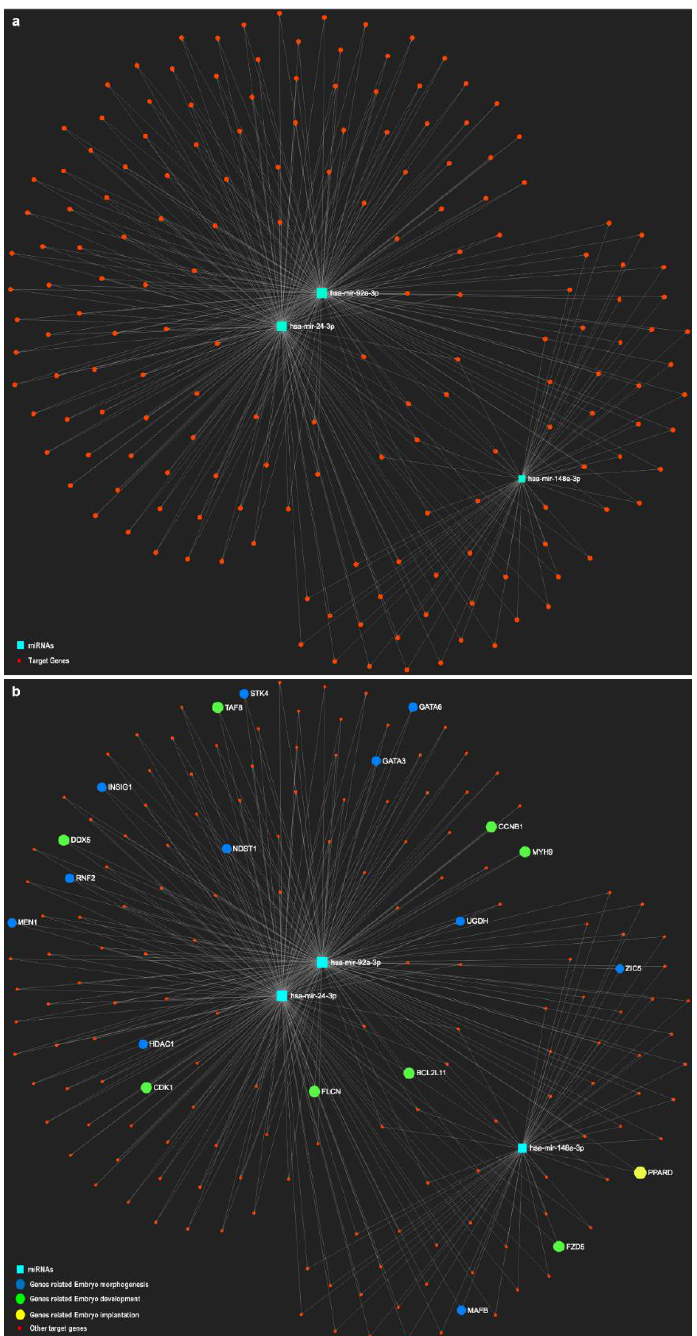
Figure 2. Networks of selected miRNAs identified in oviductal extracellular vesicles (oEVs) and contained in the embryo according to miRNet online tool with potential target genes involved in embryo development. The miRNet online tool was used to represent selected miRNAs (13) (turquoise-blue nodes) based on differential expression and high abundance in oEVs at stage 1 of the bovine estrous cycle (recently ovulated follicle; days 1-4 post-ovulation) and potential target genes (red nodes) enriched in functional categories related to embryo development (green), embryo morphology (blue) and implantation (yellow) in a network. Since the miRNet online tool allows to choose the source/tissue for the list of miRNAs, the network ( a ) represents three miRNAs contained in embryos according to the online tool database, with all target genes involved in embryo development functions ( b ).